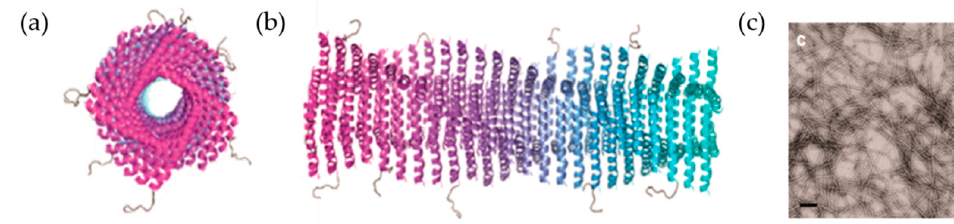
Figure 9. Self-assembled structures of Coil29 in α -helical nanofibers. ( a – b ) Axial view and side view schematics of PEPvIII epitopes displaying outward of Coil29 fibers at the N-terminus. ( c ) Negative stain TEM image of Coil29 nanofibers with a scale bar of 100 nm. Reproduced with modification from [84]. Copyright (2017) American Chemical Society.